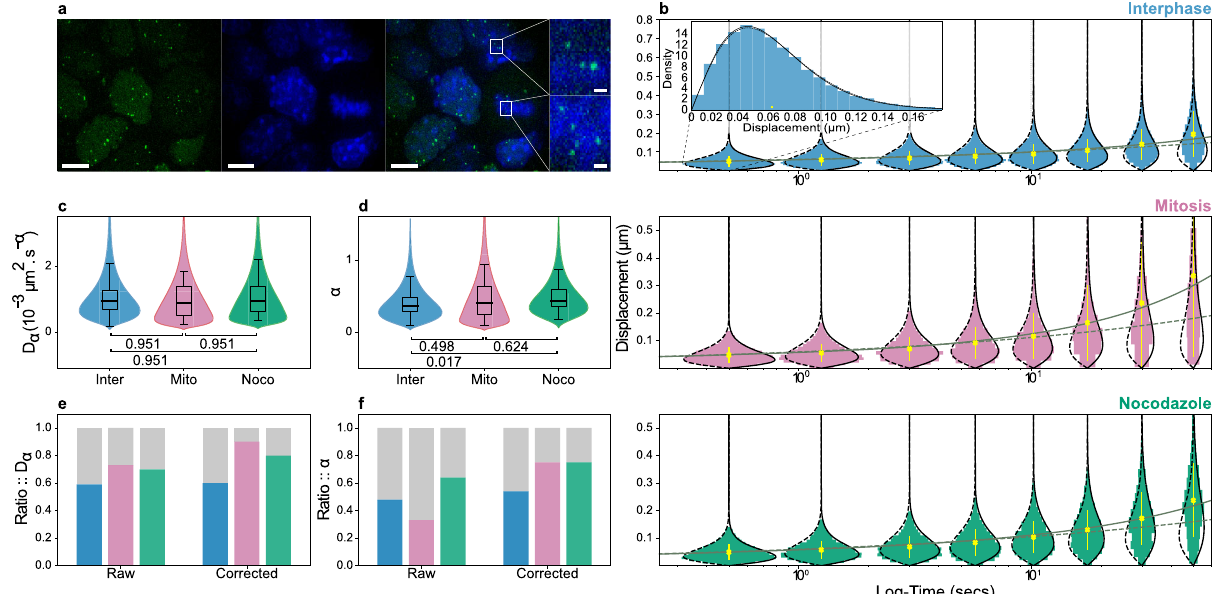
Fig. 3 Average chromatin dynamics is similar in interphase and mitosis, but are highly variable across loci. a Maximum projection images of ES cells containing spots of TetR::GFP (green) bound to TetO arrays, with DNA (blue) stained with Hoechst (scale bar is 10 μ m). Inset shows magni fi cation of the selected area (scale bar 1 μ m). b Histograms showing the displacement distributions of loci in interphase (blue), mitosis (red), or mitotic arrest (green), plotted for different time points. Theoretical distributions with and without substrate correction are shown with solid to the right and dashed black lines to the left, respectively. Inset shows a rotated displacement distribution for clari fi cation purpose. The observed mean displacement with standard deviation is shown in yellow and theoretical curves with and without substrate correction are shown in gray continuous and dashed lines, respectively. The model with substrate movement fi ts better the data, suggesting a great substrate effect, especially for active mitotic cells at greater time intervals. c , d Distribution of estimated D α and α in the three conditions, correcting for substrate movement. Boxes represent the interquartile range and whiskers 95% of the data. Medians are shown as solid lines inside the boxes. e , f Estimations of the inter-(gray) and intra-cell (color) proportions of total variance for D α and α in interphase (blue), mitosis (red), and mitotic arrest (green). The number of spots analyzed in interphase, mitosis, and nocodazole tratement were n = 249, n = 23, and n = 36, respectively, over a total of 3 independent experiments. Source data are provided as a Source Data fi